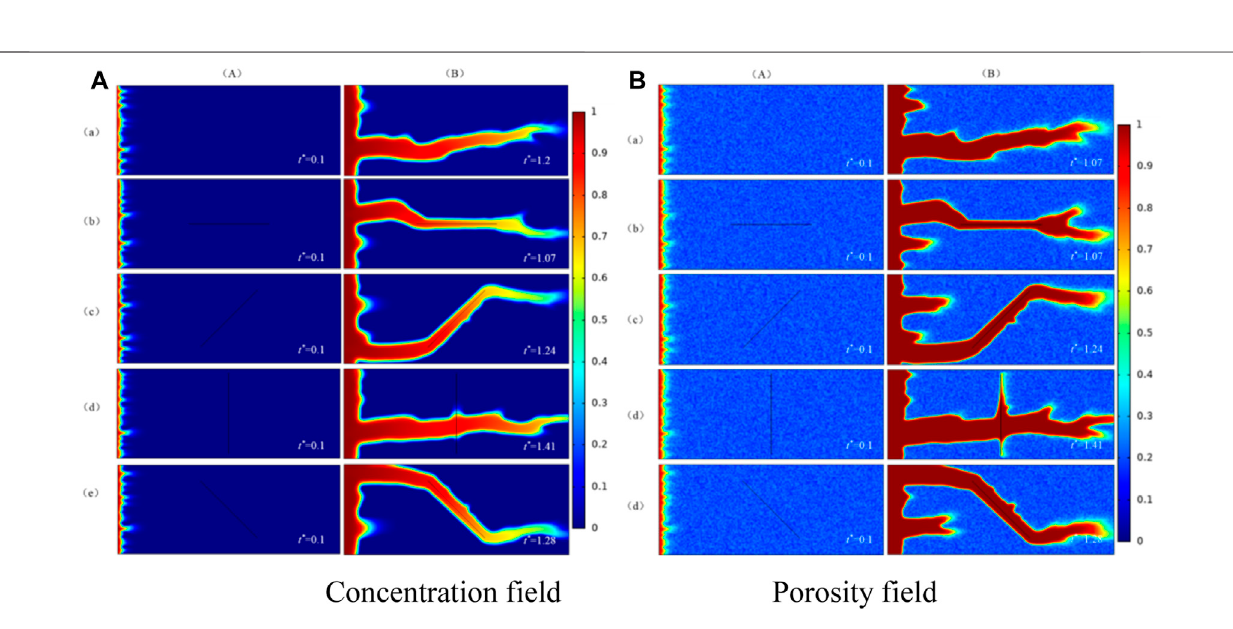
Frontiers in Earth Science |